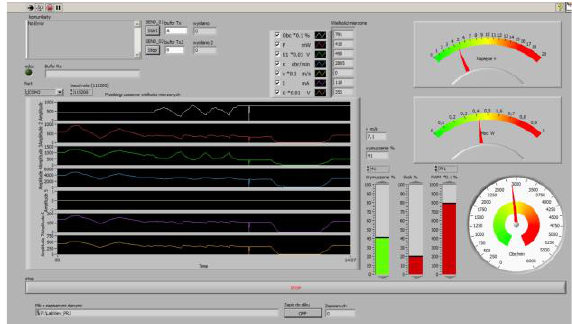
Figure 8. Virtual measuring and control device — front panel.